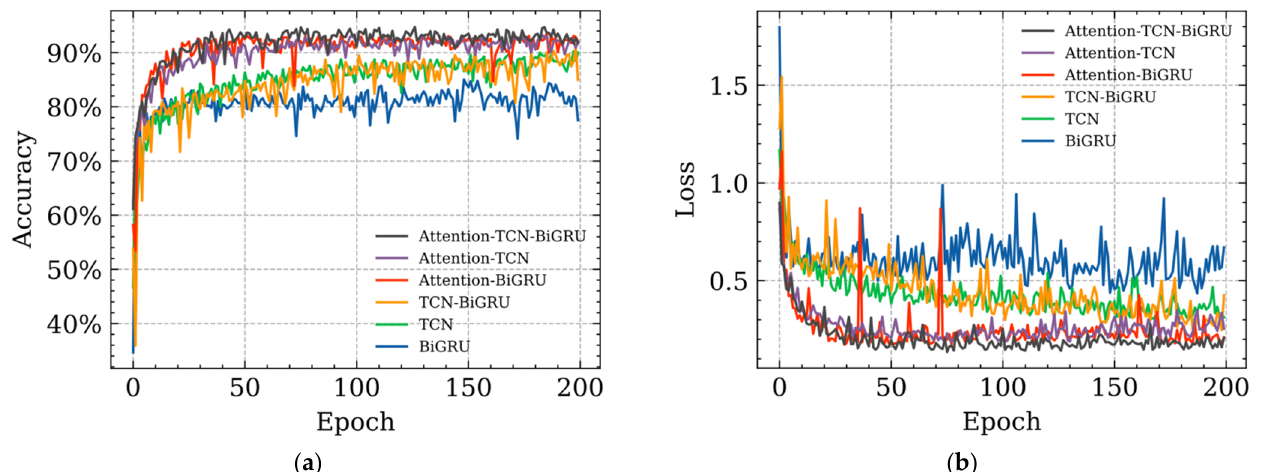
Figure 15. Changes in accuracy and loss in ablation experiments: ( a ) Accuracy rate of ablation experiment; ( b ) loss value of ablation experiment.